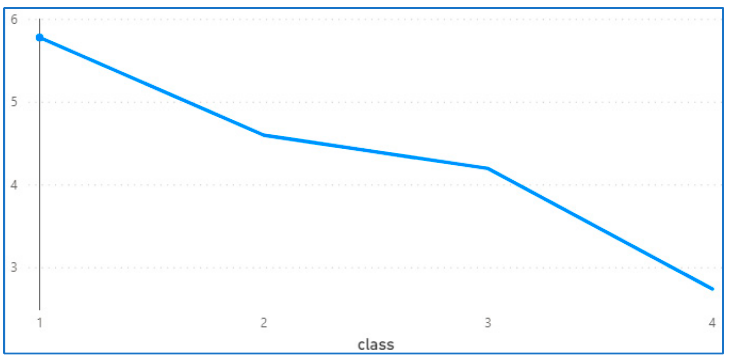
Figure 15. Housing quality index.